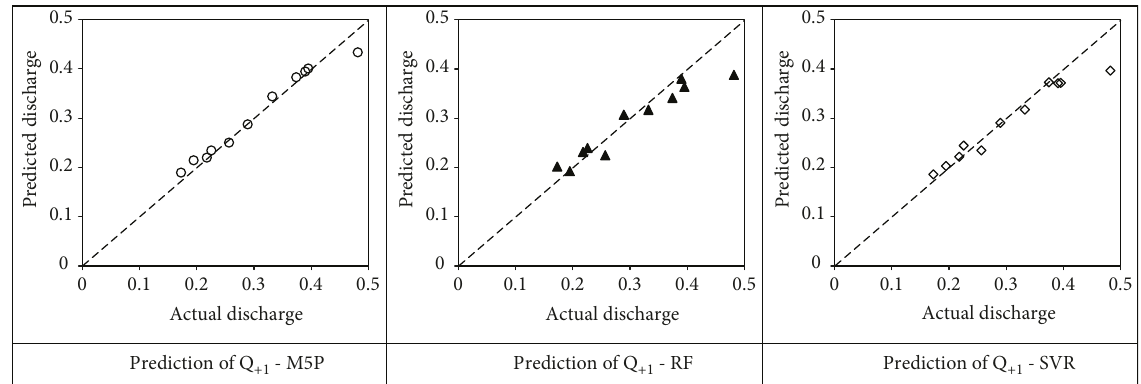
Prediction of Q + 1 - M5P Prediction of Q + 1 - RF Prediction of Q + 1 - Figure 9: Comparison between predicted and observed discharges (m 3 /s), 6-month input.